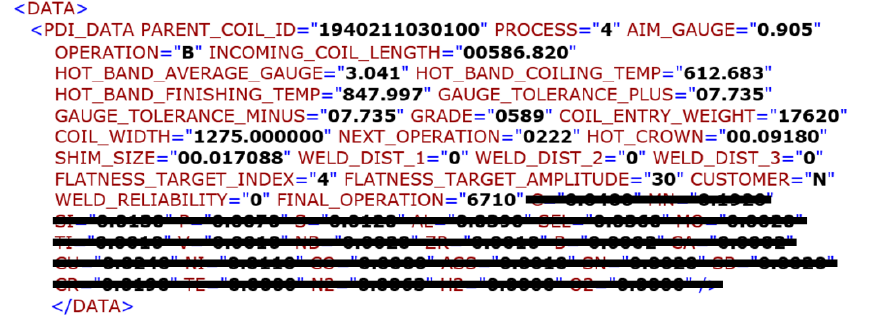
Figure A1. An example of a PDI data telegram in the HTML format from the cold-rolling mill. Four-seat tandem rolling mill. Initial strip thickness: 3.041 mm; exit thickness: 0.905 mm. Technological steel code 589, strip width: 1275 mm. Roll weight: 17,620 kg; strip coiling temperature at hot-rolling plant: 612 °C.